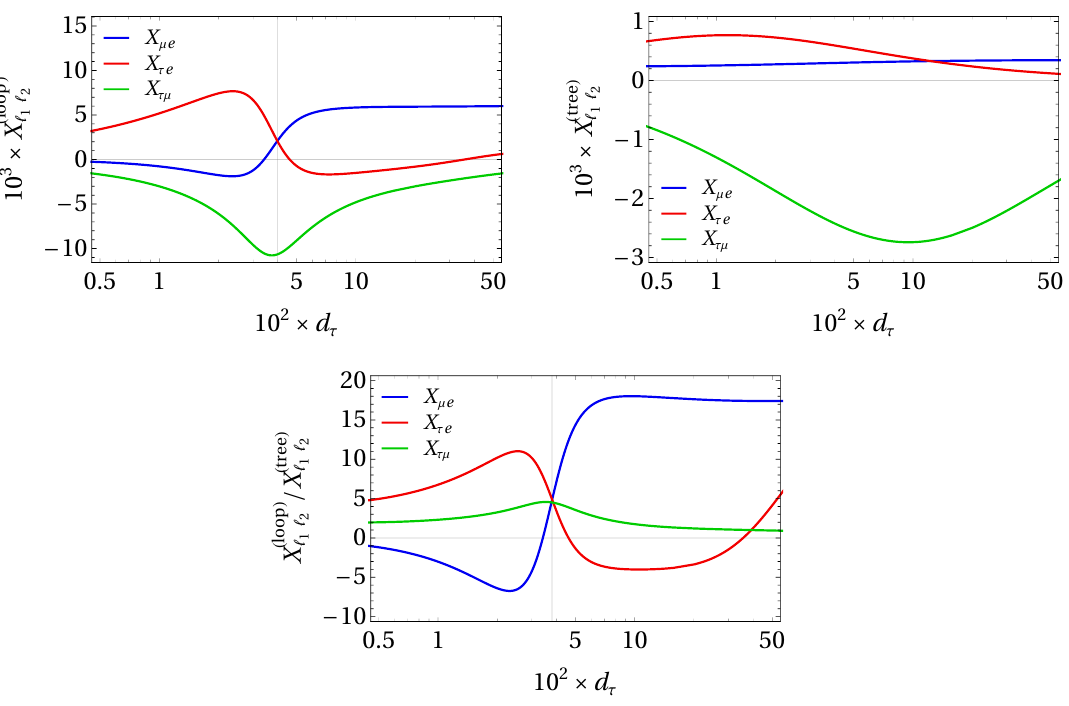
(top-right panel), and X (loop) ‘ 1 ‘ 2